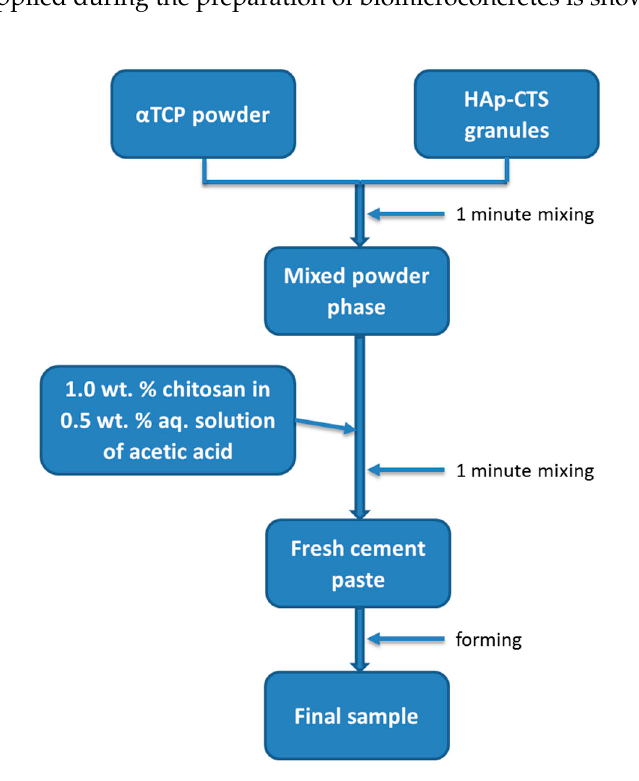
Figure 2. The flow chart of the preparation procedure.